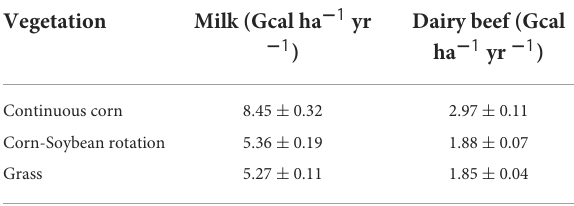
TABLE 2 Average ± standard errors for food-energy production across three vegetation types.